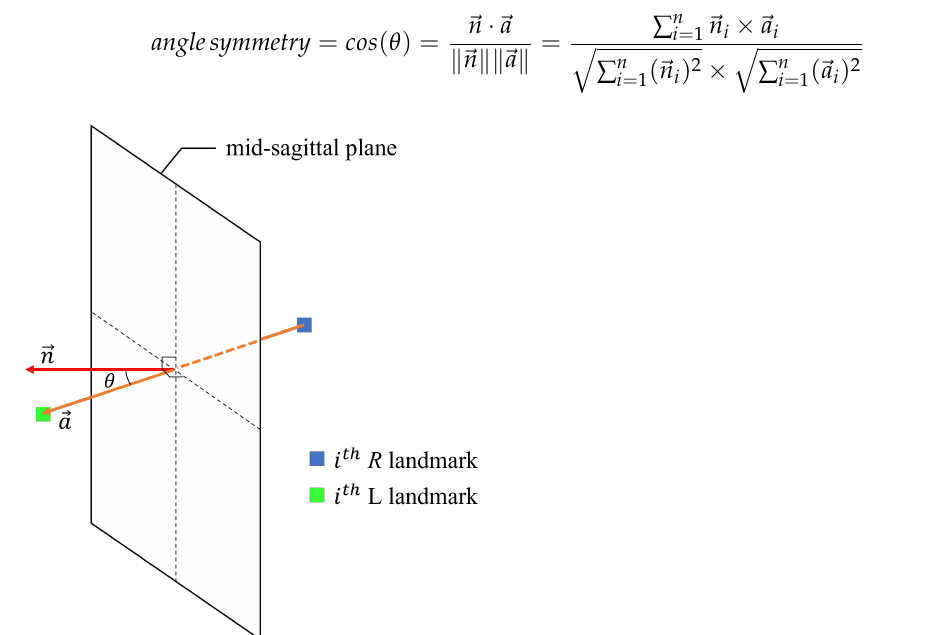
Figure 6. Angle symmetry through the cosine similarity of the normal vector of the midsagittal plane and the landmark pair